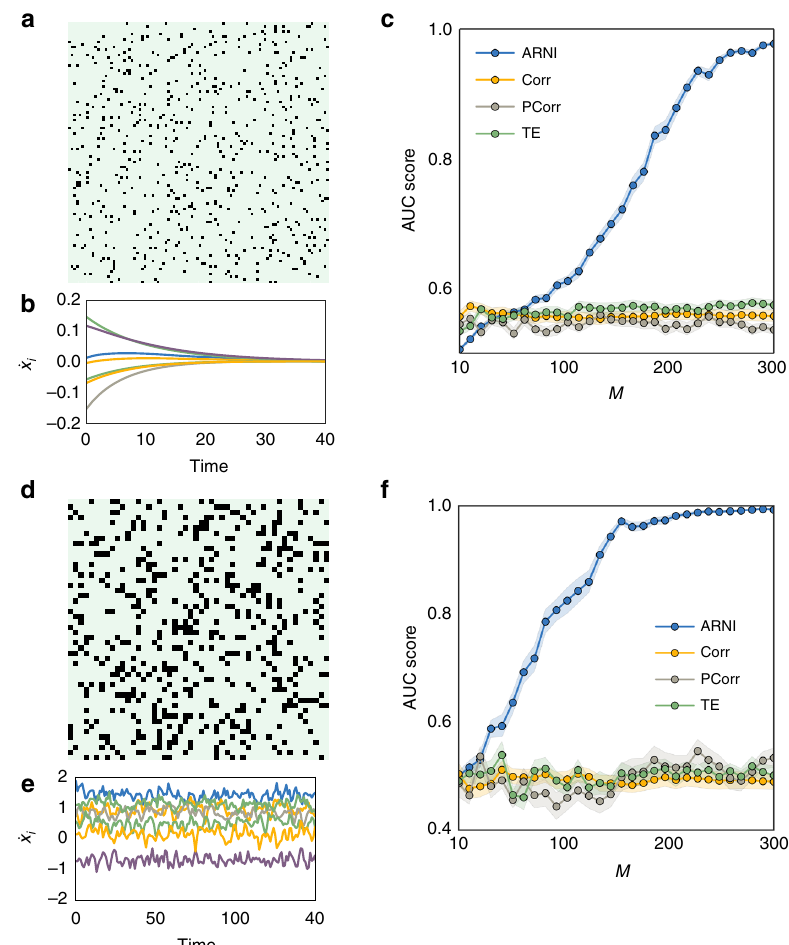
Fig. 2 Inferring interactions from transients to steady state and from non-periodic dynamics. We simulated short transient time series of m = 5 time points starting from different initial conditions and created composite longer time series as in Fig. 1. Thus M = S × m , where S is the number of distinct transient dynamics. a – c Revealing interactions from transients toward steady state. a Adjacency matrix of a network of N = 100 units under Michaelis – Menten kinetics with n i = 10 incoming connections. b Example of transient dynamics toward steady states, where _ x j ¼ 0 for all j ∈ {1, 2, ..., N }. c Quality of inferences with respect to M using our approach (ARNI), correlations (Corr), partial correlations (PCorr), and transfer entropy (TE). d – f Revealing interactions from non-periodic dynamics. d Adjacency matrix of a network of N = 50 phase-coupled oscillators with n i = 10 incoming connections (black squares) per unit. e Example of derivatives for several oscillators. f Quality of reconstruction from short trajectories with respect to M = S × m with m = Performance . To further characterize the performance of our approach, we carried out systematic reconstructions of various networks of different sizes, numbers of incoming connections per unit, noise levels, fraction of higher-order (hypernetwork) inter- actions, and number of hidden units (Fig. 4). We report four classes of results. First, the number M θ of time points necessary for AUC scores larger than a threshold θ scales sublinearly with the size of the network, Fig. 4a, and linearly with the number of incoming connections per unit, Fig. 4b. Moreover, inferring the incoming connections of single units in large sparse networks ( N = 10) in conventional hardware (Intel ® Core TM i5- = 1000, n i 2430M) takes 65 ± 26 s per unit. Such results highlight the potential applicability of our approach in combination with parallel computing for revealing interactions in real-world net- works, which are often large in size and sparsely connected. Second, M θ depends supralinearly on the noise level η , Fig. 4c. Here, sampling longer time series (more data) improves recon- struction quality. These results indicate that inference is still viable for highly noisy dynamics at the expense of recording longer time series. Third, systematic reconstructions of